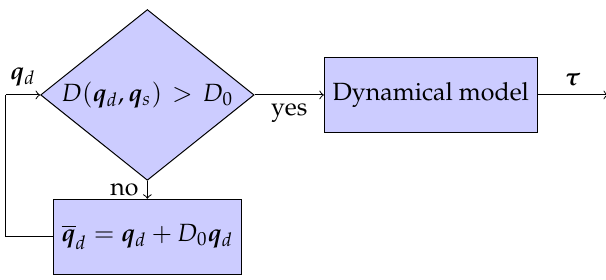
Figure 6. Proposed control scheme in presence of